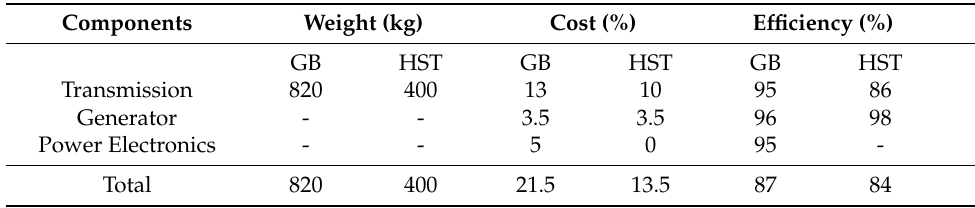
Table 3. Comparison between an HST and a gearbox wind